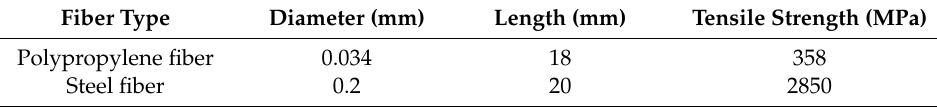
Figure 1. Gradation of river sand used in this study. Table 6. Physical properties of polypropylene fiber and steel fiber.